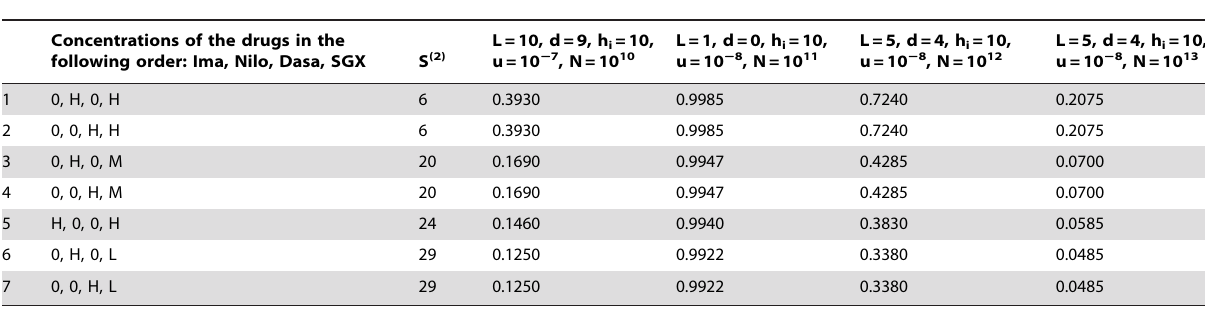
Table 5. Set B 2 after step 3 of Algorithm